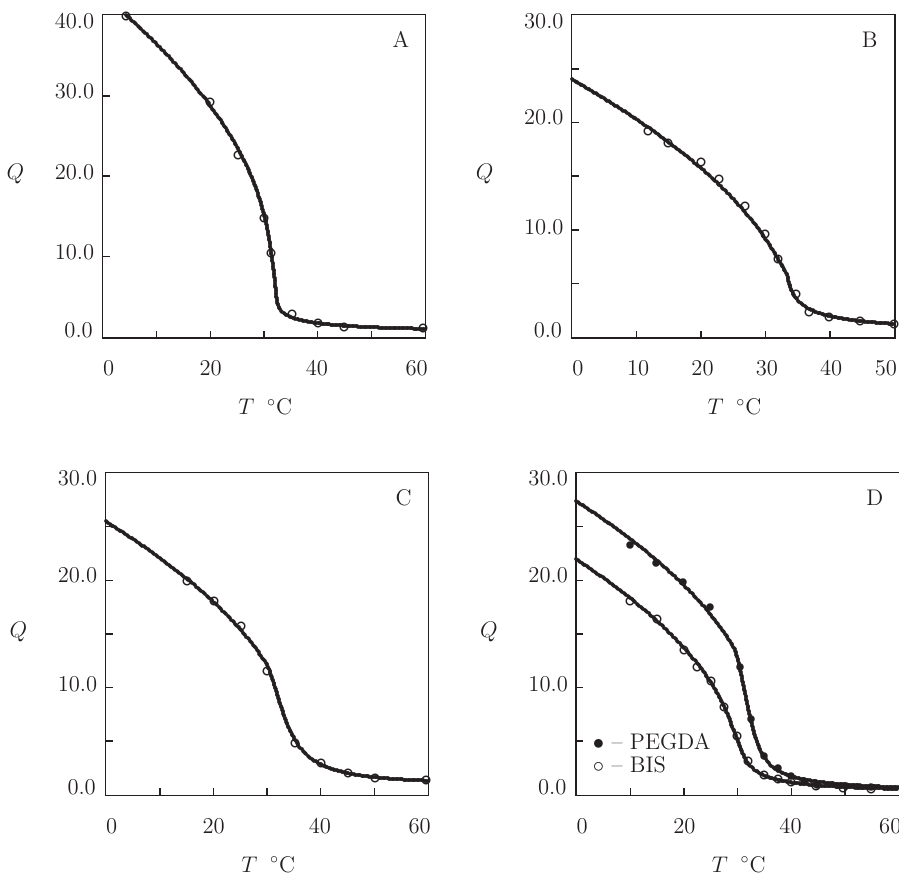
Figure 3. Degree of swelling Q versus temperature T . Symbols: experimental data on PVCL macro- and microgels (( A ) [52], ( B ) [53], ( C ) [54], and ( D ) [55]). Solid lines: results of